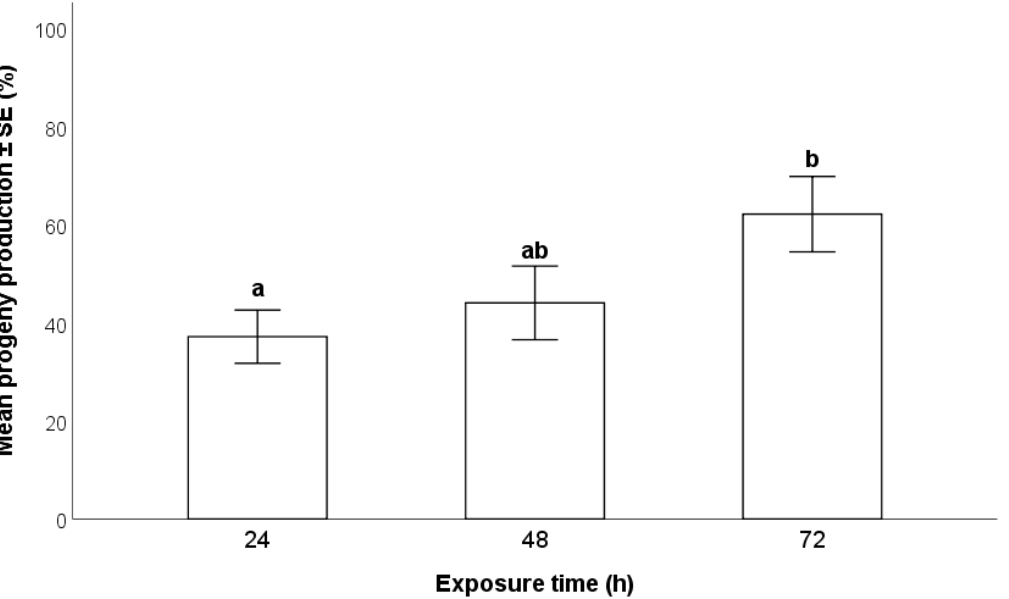
Figure 4. Effects of exposure time of an egg mass (stored prior to exposure at 6 °C for 28–50 days) to a single Trissolcus japonicus female on the production of progeny (GLM, p < 0.05). Different letters indicate significant differences ( p < 0.05) as detected by multiple comparison with sequential Bonferroni adjustment.